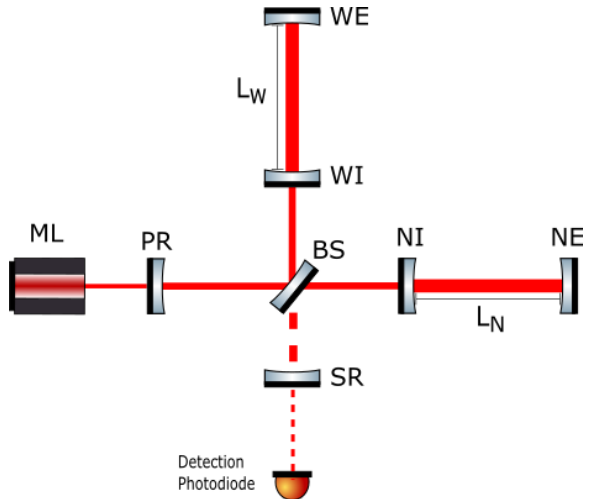
Figure 1. Optical configuration of Advanced Virgo+. The laser light provided by an amplified master laser (ML) is transmitted by the power recycling mirror (PR) and split into two by the beam splitter (BS). The two beams are then injected into the 3 km long arm cavities, where the input mirrors (NI and WI) and the end mirrors (NE and WE) form two stable resonators whose lengths are indicated as L N and L W respectively. At the dark port an additional recycling cavity is added thanks to the Signal Recycling mirror